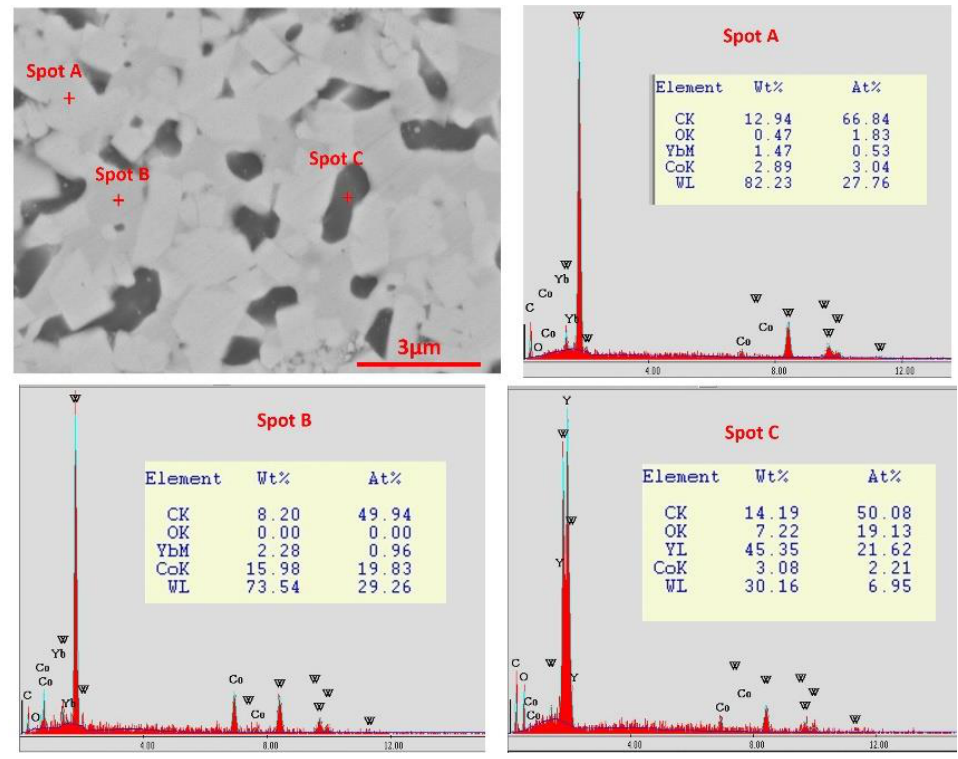
Figure 10. EDS analysis of the three phases observed in the consolidated WC-Co-TaC-NbC with 7.5 wt% Y 2 O 3 . Spot A = white (WC) phase; Spot B = gray (η, Co 3 W 3 C) phase; and Spot C = black 7.5 wt% Y 2 O 3 . Spot A = white (WC) phase; Spot B = gray ( η , Co 3 W 3 C) phase; and Spot C = black (yttrium oxide) phase. (yttrium oxide)